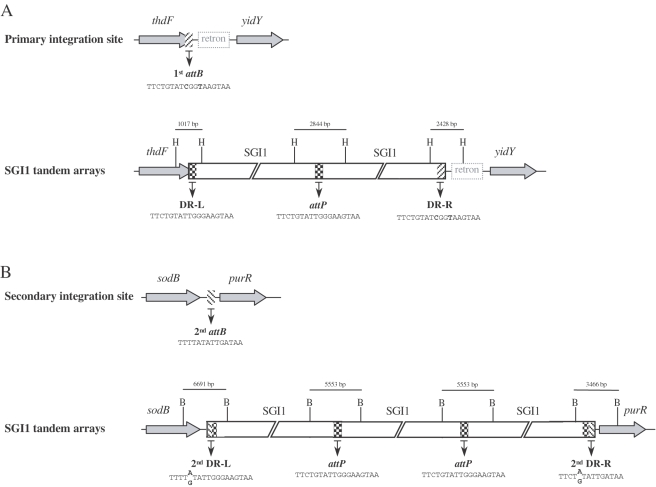
Chromosomal integration sites and tandem arrays of SGI1 in the S. Typhimurium chromosome.(A) Schematic view of the primary specific integration site (1st
attB) of SGI1 within the 3′ end of the chromosomal thdF gene of different S. Typhimurium strains. The retron sequence downstream the 1st
attB site is only present in S. Typhimurium strains. The integration of SGI1 tandem arrays (2 copies) in its 1st
attB site is represented. Positions of HindIII restriction sites (H) are indicated without respect of bp scale to show the expected sizes of HindIII fragments corresponding to 1st DR-L, 1st DR-R, and attP. (B) Schematic view of the secondary integration site (2nd
attB) of SGI1 between the chromosomal sodB and purR genes. The integration of SGI1 tandem arrays (3 copies) in the 2nd
attB site is represented. Positions of BglI restriction sites (B) are indicated without respect of bp scale to show the expected sizes of BglI fragments corresponding to 2nd DR-L, 2nd DR-R, and attP. The sequences of 1st
attB, 2nd
attB, attP, DR-Ls, and DR-Rs are indicated.